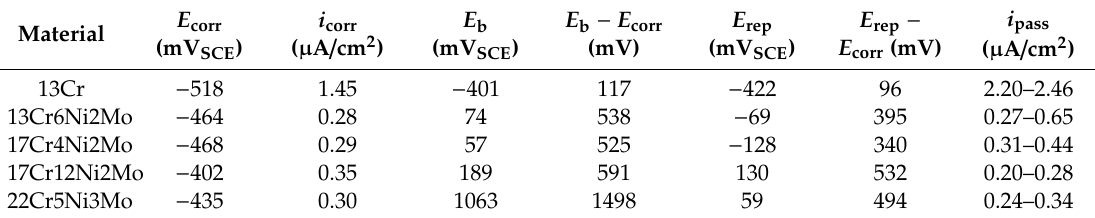
Figure 2. Electrochemical data derived from the cyclic polarization tests are given in Table 2. Table 2. Electrochemical data from potentiodynamic measurements of investigated materials in 30,000 ppm Cl – at 30 °C, 1 bar CO 2 , 200 mV/h.